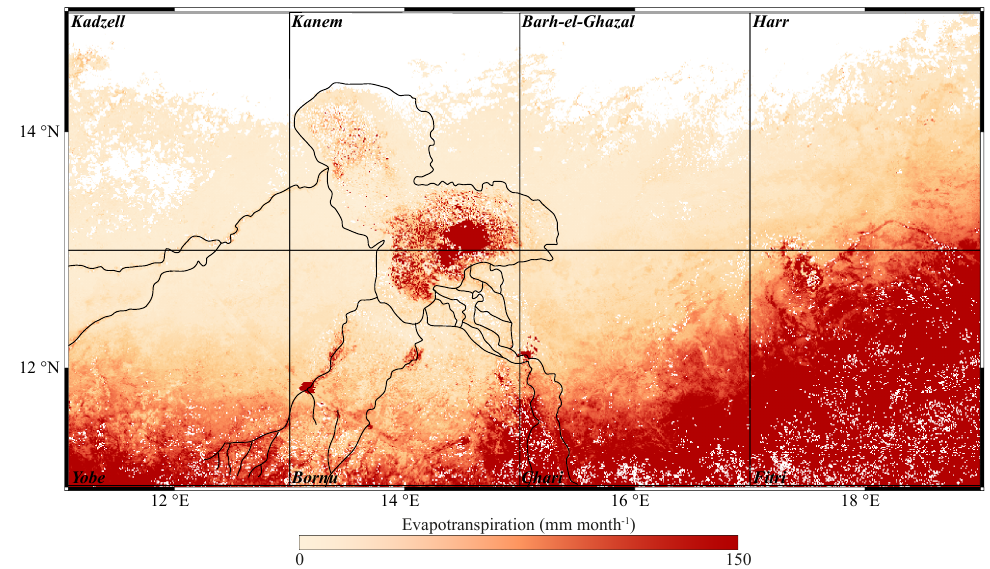
Figure 9. MODIS evapotranspiration map from the MOD16 algorithm. This map also represents the 1960’s spatial extension of Lake Chad and its main tributaries. Black squares highlight the limits of the GRACE tiles.